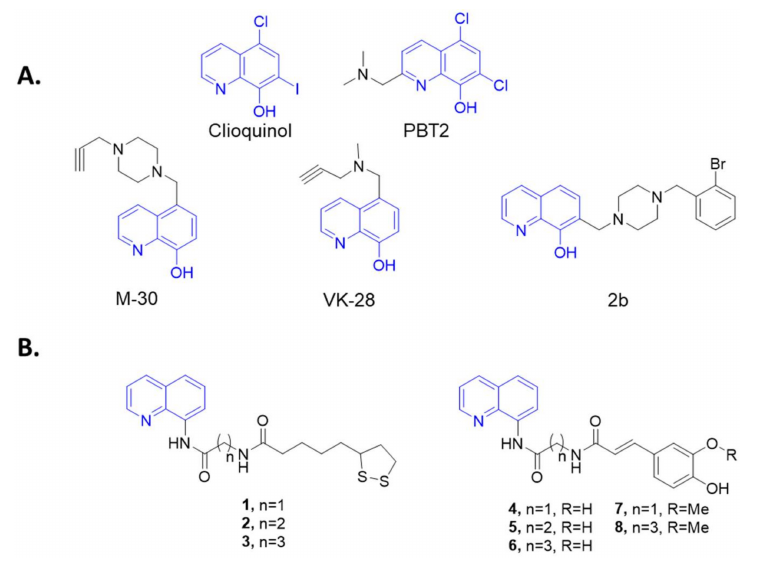
Figure 1. ( A ) Structures of M-30, VK-28, and 2b; ( B ) General structure of designed compounds merging 8-aminoquinoline scaffold with natural acids are reported in the